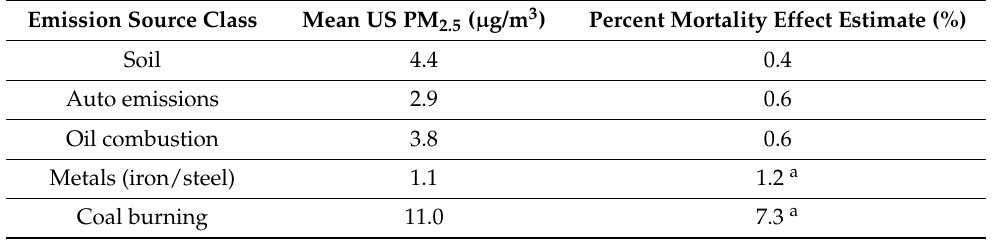
Table 4. Mean source contributions and their mean effects on 1980 mortality in 36 US MSAs